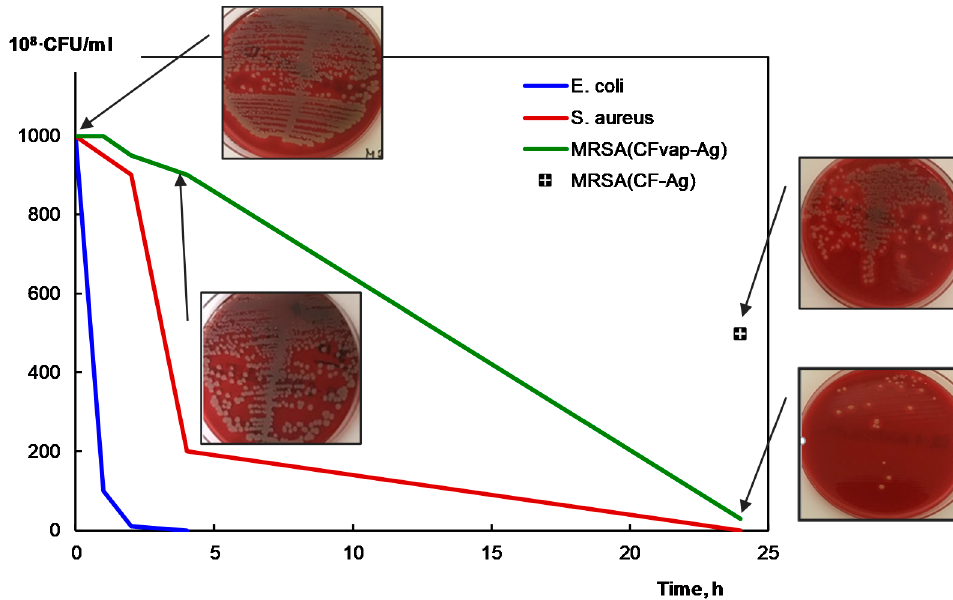
Figure 11. Number of bacteria colonies as a function of the incubation time with CFvap–Ag nanohybrid on agar plates ( p < 0.01; n = 4). The photographs inserted show plates initially supplemented with 10 8 CFU/mL of MRSA and incubated with CF–Ag and CFvap–Ag nanohybrids for different periods.